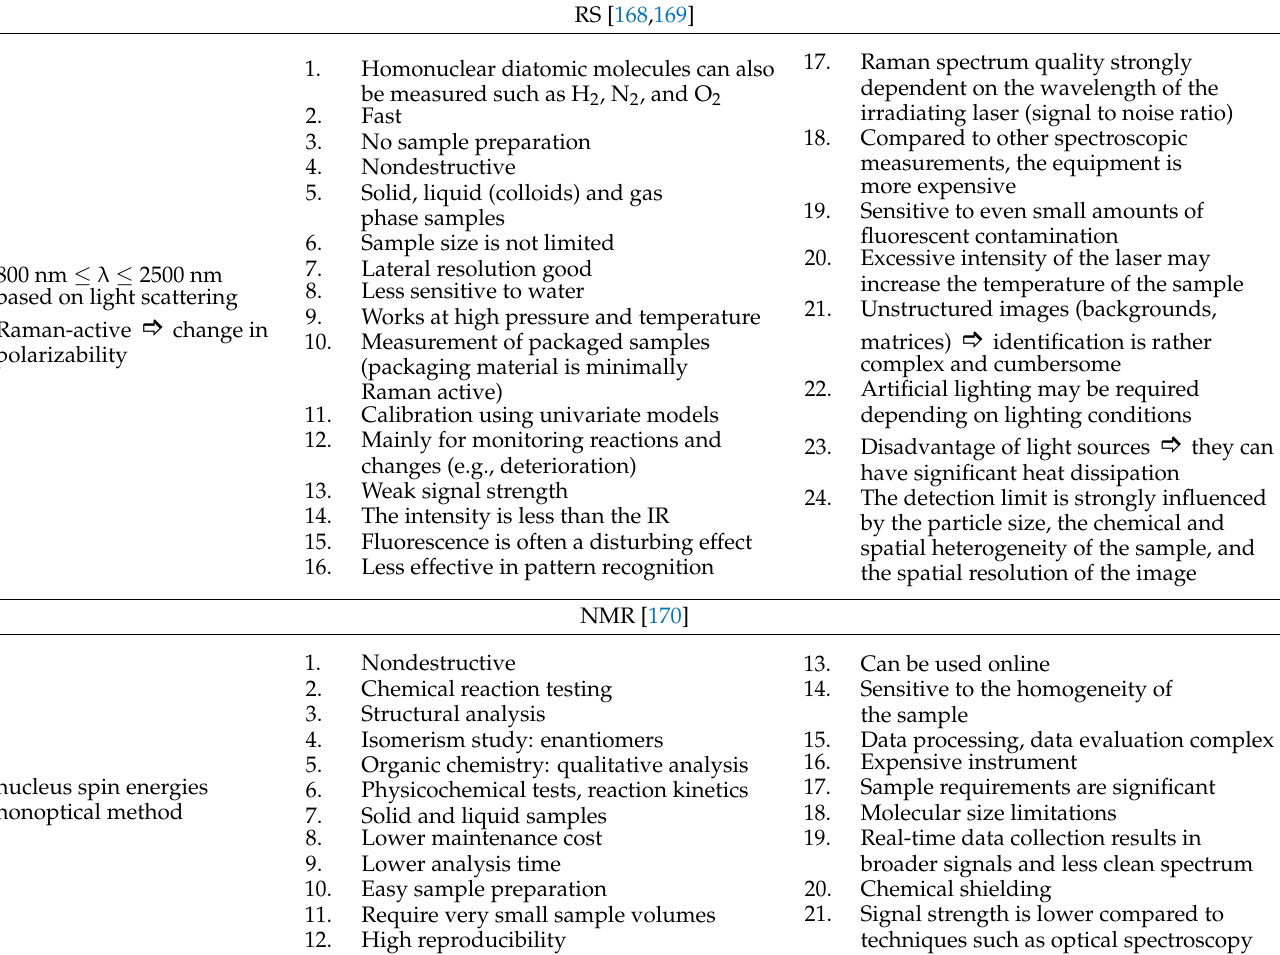
Table 2. Advantages and disadvantages of different molecular spectroscopy methods.